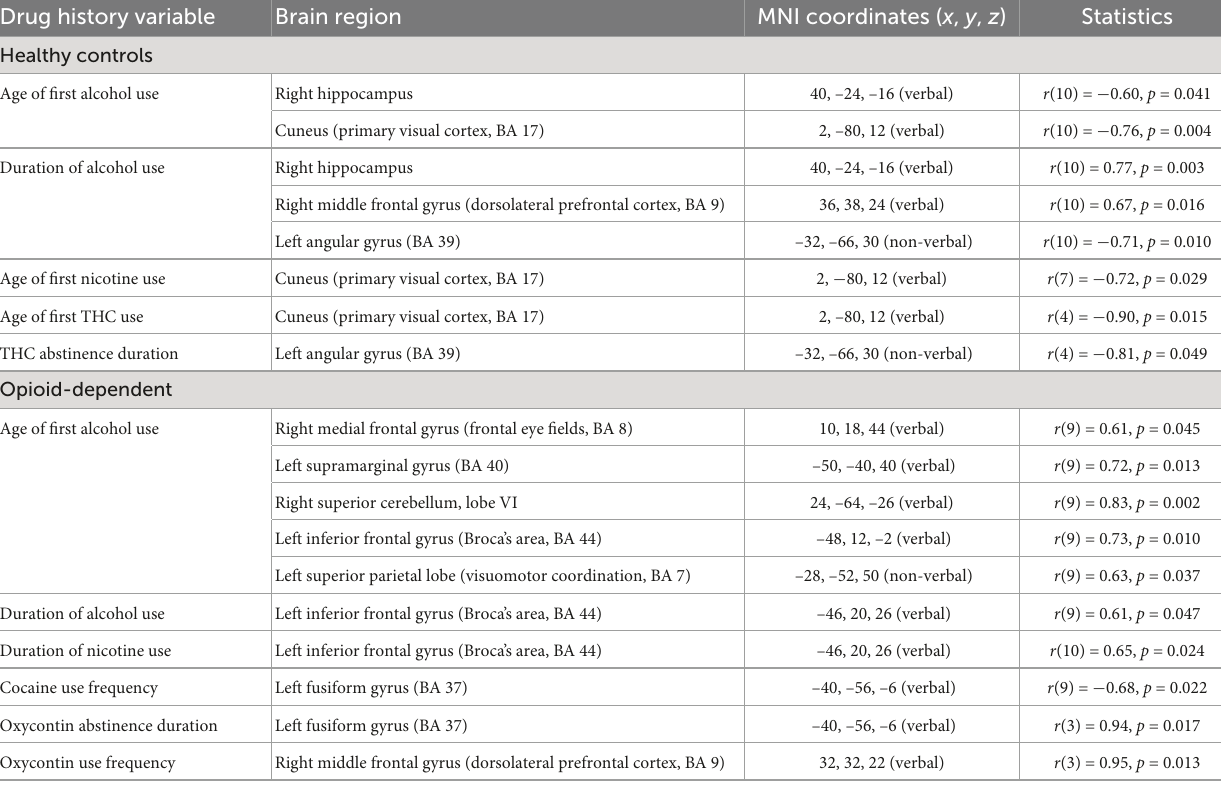
TABLE 5 Significant correlations between drug history variables and regions of interest (ROIs). Drug history